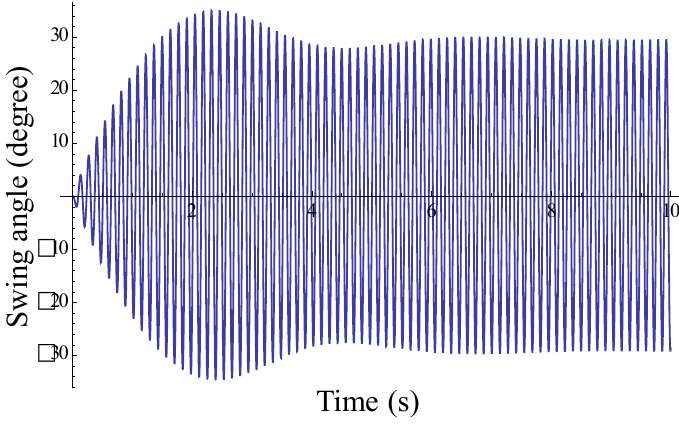
Figure 3. Transient response of the swing angle at the car speed 50 km/h and initial conditions